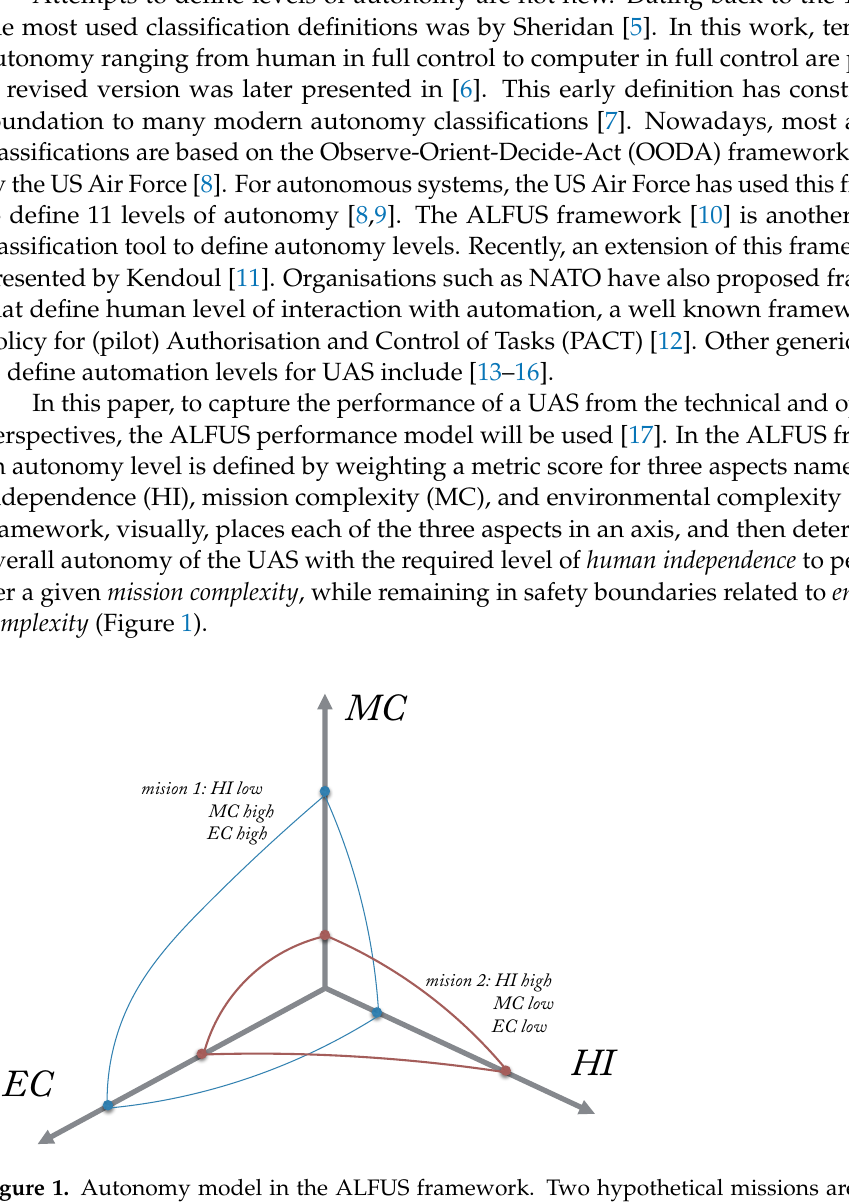
Figure 1. Autonomy model in the ALFUS framework. Two hypothetical missions are shown to exemplify the relationship between mission complexity ( MC ), environmental complexity ( EC ) and human independence ( HI